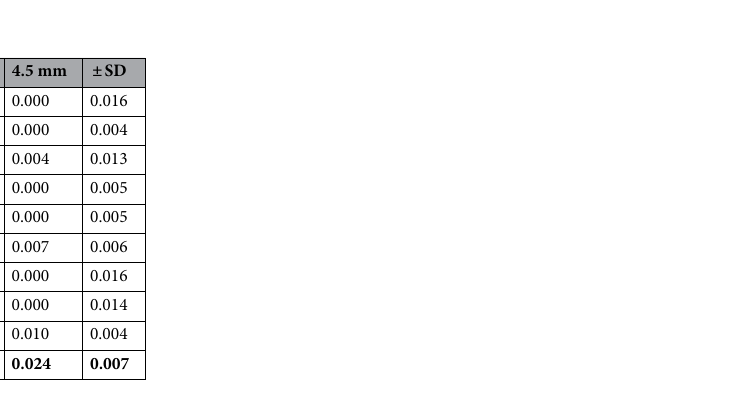
Table 3. ICL Coma-like and Spherical-like Zernike coefficients obtained for the pupil sizes of 3 mm and 4.5 mm. High Order RMS aberrations (HORMS) were calculated onsidering the Zernike coefficients from the third to eighth